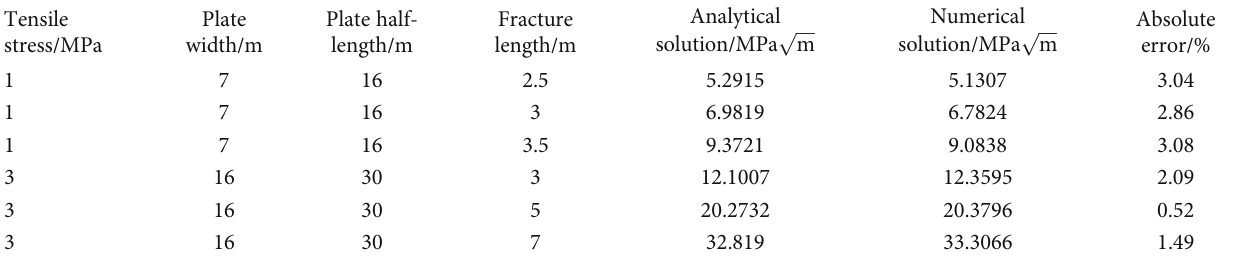
Table 1: Comparison between theoretical and numerical solutions of SIF at the crack tip.